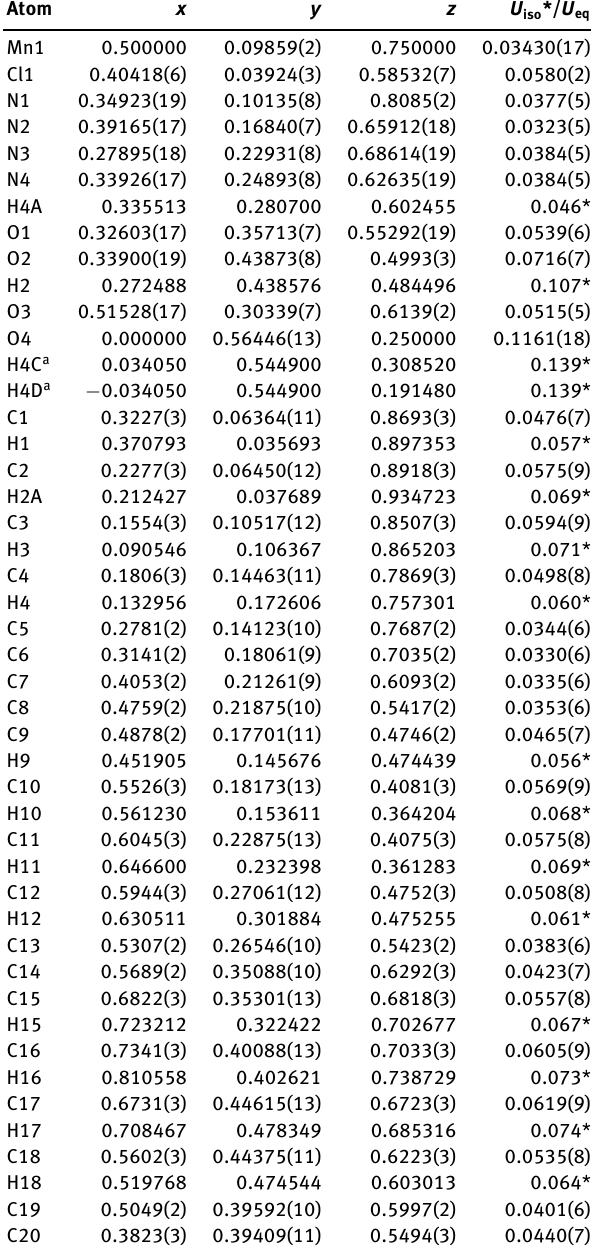
Table 2: Fractional atomic coordinates and isotropic or equivalent isotropic displacement parameters (Å 2